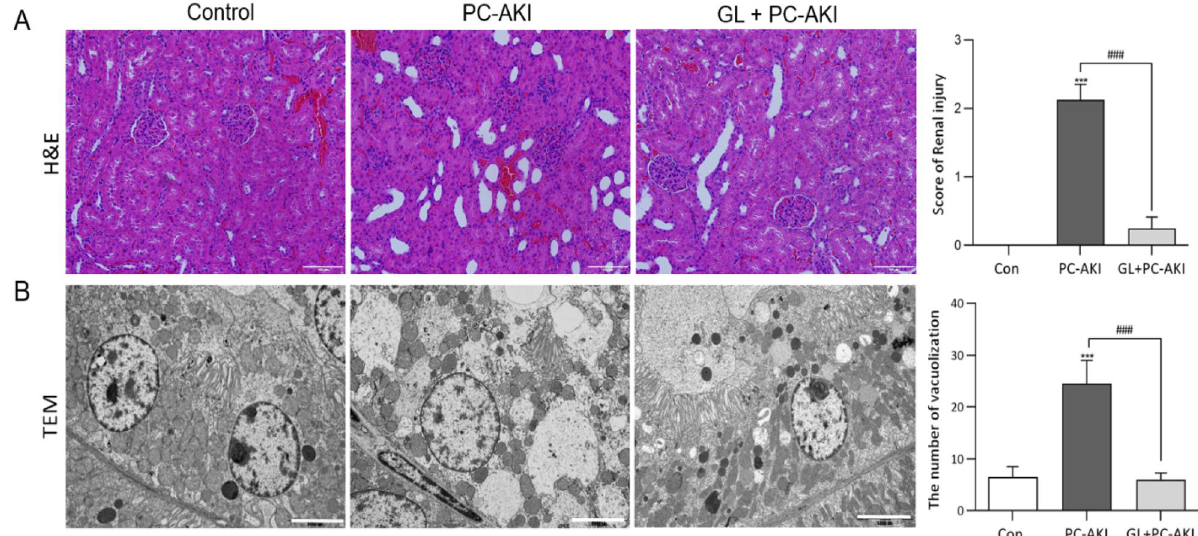
Figure 7. Effect of glycyrrhizin on kidney histology. (A) Histological appearance of kidney tissue after H&E staining. Compared to the controls, renal tubular dilatation was prominent in PC-AKI, whereas it was mitigated in the PC-KAI with glycyrrhizin group. Magnification = 20X, Scale bar = 100 μm. (B) Transmission electron microscopy (TEM) images show multiple large vacuoles in the cytoplasm of the PC-AKI group, but this phenomenon was alleviated in the PC-AKI with glycyrrhizin group. Magnification = 5 K, Scale bar = 5000 nm (B-C). Statistical significance: *** P < 0.001 Con vs PC-AKI, ### P < 0.001 PC-AKI vs PC-AKI + GL. Abbreviation: PC-AKI, post-contrast acute kidney injury; GL, glycyrrhizin; TEM, transmission electron